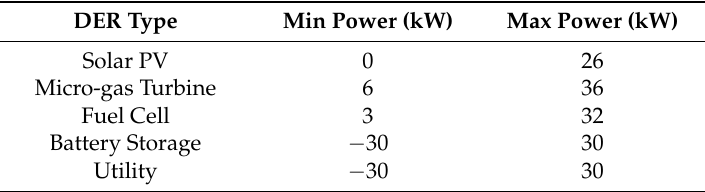
Table 3. Installed distributed energy resources in the MG.